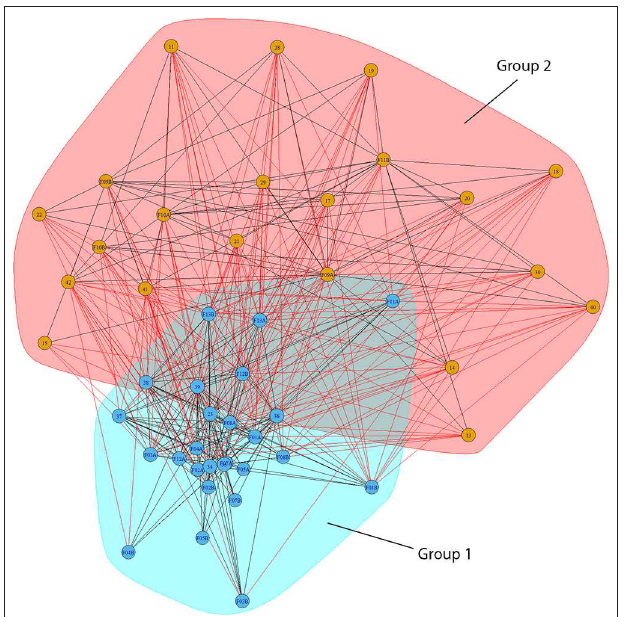
FIGURE 4 | Bipartite graph of network analysis from Hemnfjord tracking data including marine receivers (two-digit numbers) that were operative from 2012 to 2014 and tagged fish tracked for two consecutive seasons (two-digit number with F as prefix and ending with A for first year of tracking, ending with B for second year of tracking). Lines indicate connections (edges) between receivers and the detected fish. Color indicate the different subgroups (communities) of receivers and associated tracked fish assigned by a random-walk-algorithm.